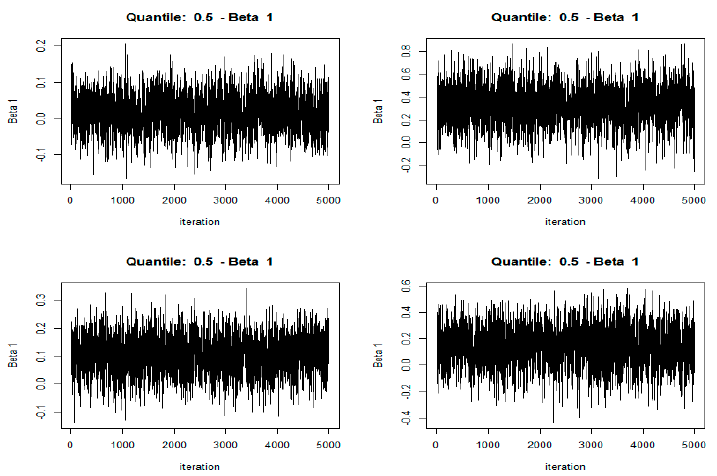
Figure 3. Traceplots of the MCMC (Markov Chain Monte Carlo) chains for intercept (the upper left), HCE (the upper right), CO 2 (the lower left), and INCOME (the lower right) for BQR.